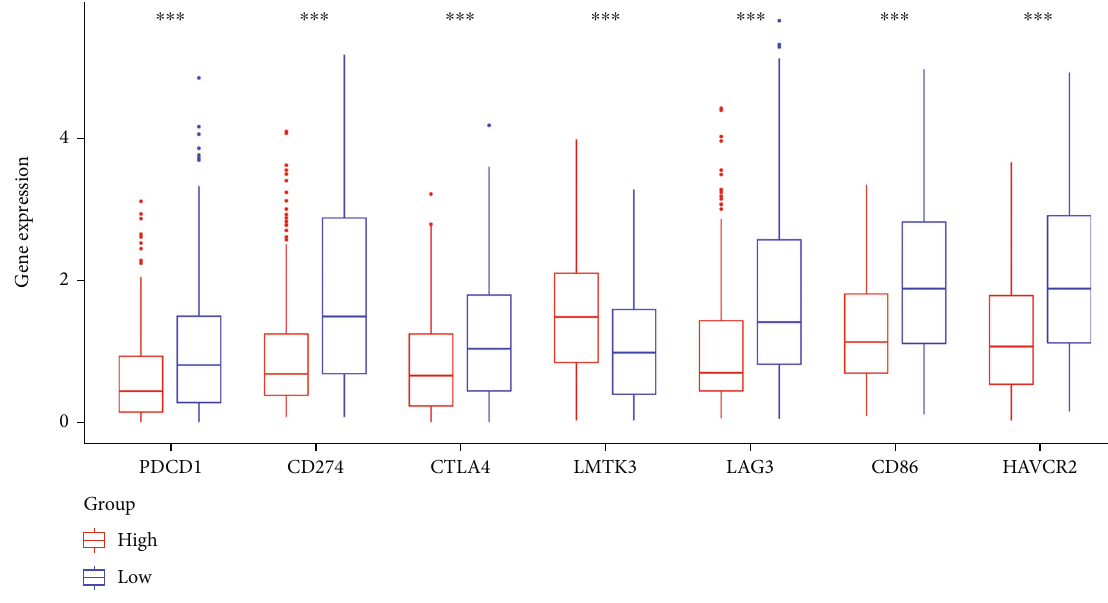
Figure 8: Relationship between FGFR3 and common immune